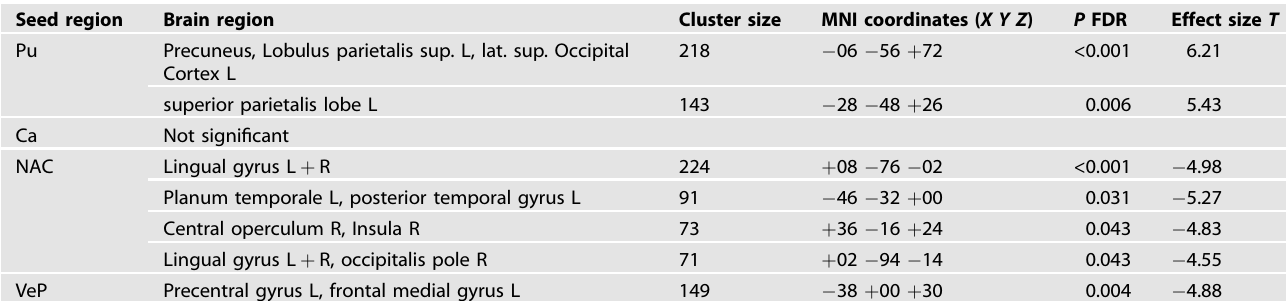
Table 3. Correlation of polygenic risk with the dopaminergic